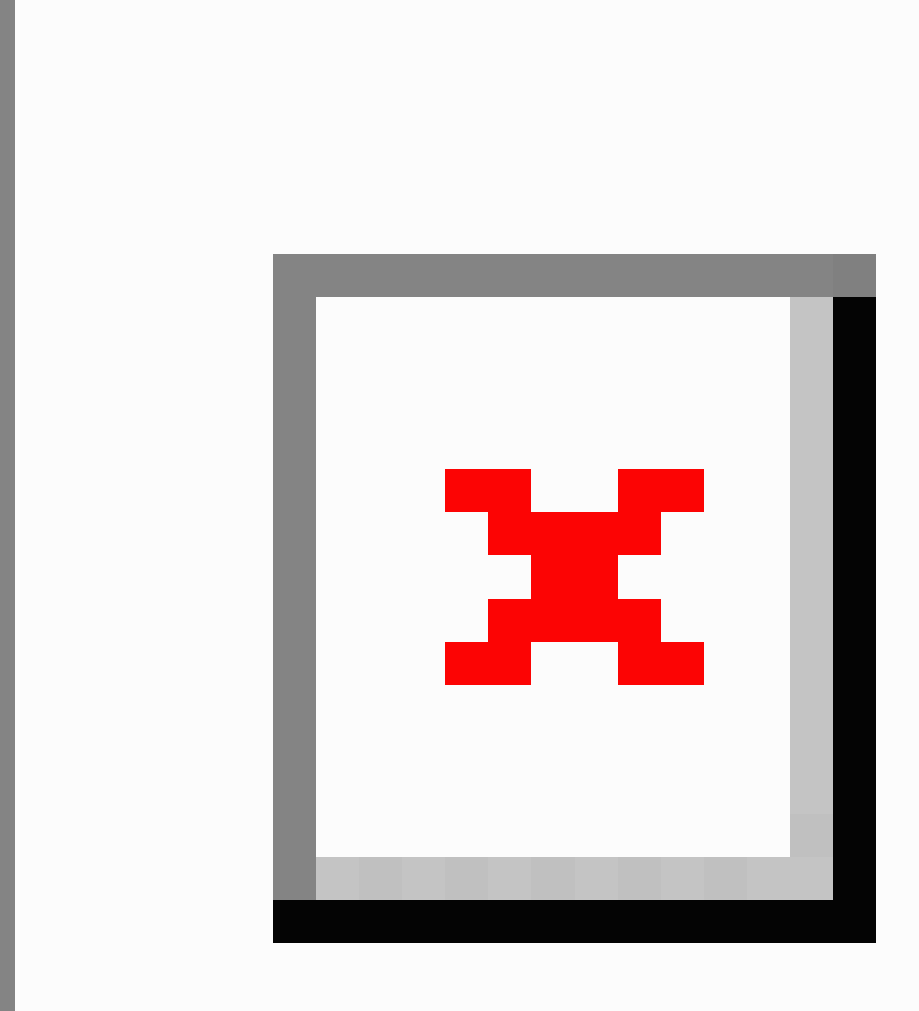
Figure 4. Main dashboard: Patient